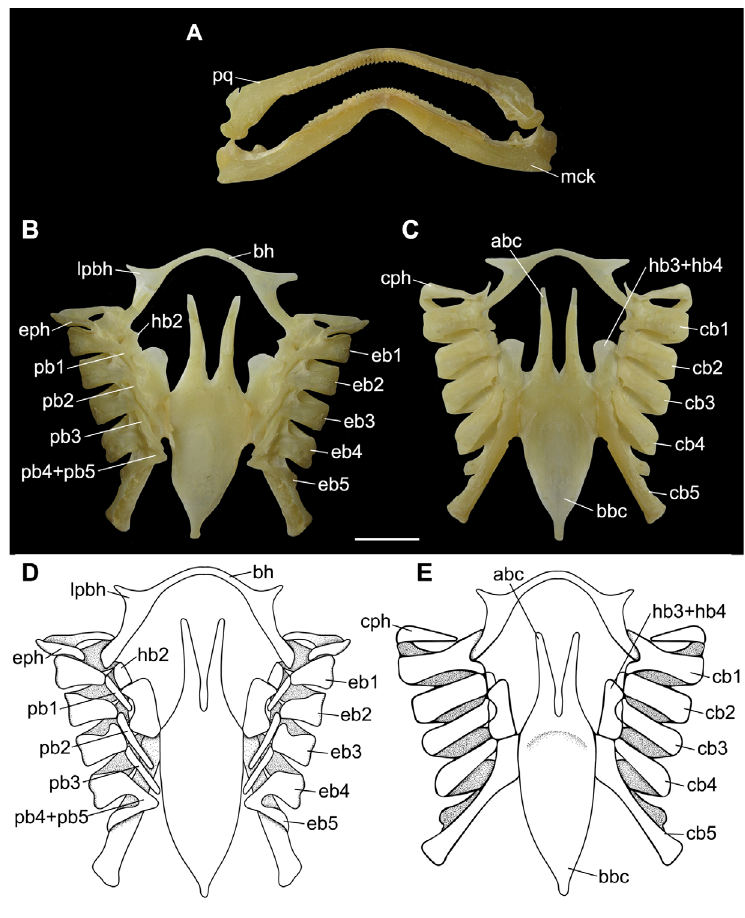
FIGURE 7 | Visceral arches of Rioraja agassizii , MNRJ 50512, female, 505 mm TL. A. jaws; B , D. dorsal and C , E. ventral views of hyoid and gill arches. abc , anterior portion of basibranchial copula; bbc , basibranchial copula; bh, basihyal; cb 1–5 , ceratobranchials I–V; mck , Meckel’s cartilage; cph , cerato-pseudohyoid; eb 1–5 , epibranchials I–V; eph , epi-pseudohyoid; hb 2–4 , hypobranchials II–IV; lpbh , lateral projection of basihyal; pb 1–5 , pharyngobranchials I–V; pq , palatoquadrate. Scale bar = 5